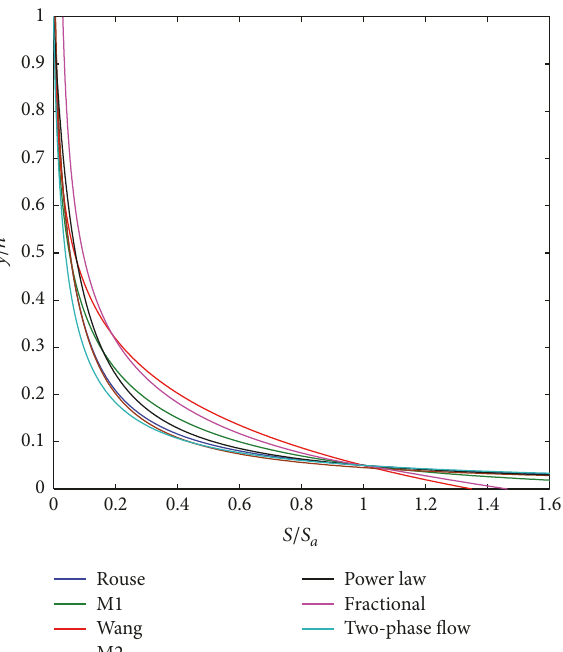
Figure 2: Numerical results of different models in describing the vertical distribution of sediment suspension. Von Karman constant 𝜅 = 0.4 , shear velocity 𝑢 ∗ = 0.10 , sediment settling velocity 𝜔 = 0.04 , water depth ℎ = 1.0 , 𝑎 = 0.05ℎ , and 𝛼 = 0.9 in the fADE model. For description simplicity, units are not used for parameters in this